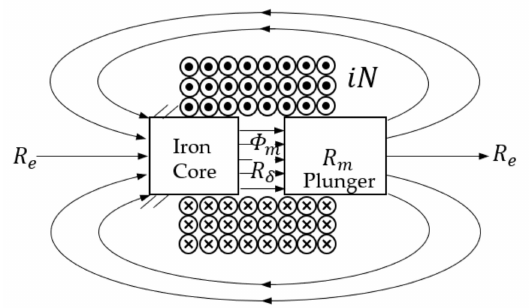
Figure 3. Diagram of magnetic circuit of the on–off